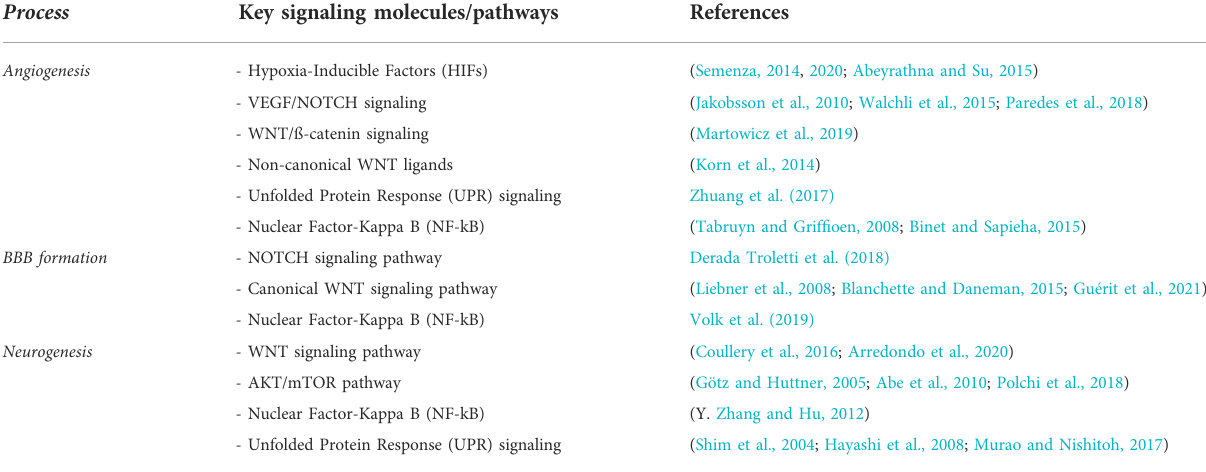
TABLE 1 Major molecular participants underlying neurodevelopmental processes of angiogenesis, BBB formation, and neurogenesis.